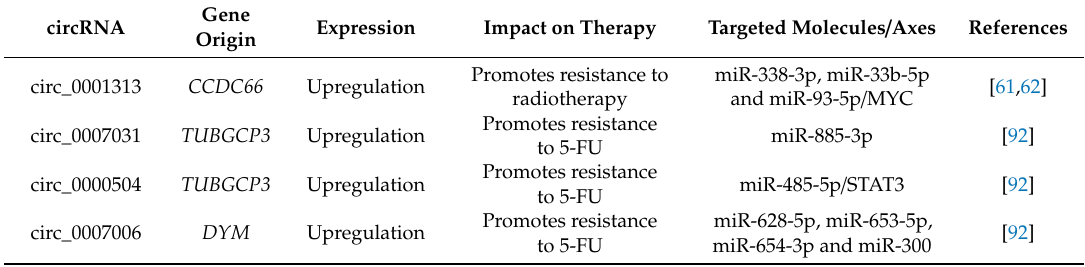
Table 2. circRNAs upregulated or downregulated in CRC, with the implication in therapy resistance.